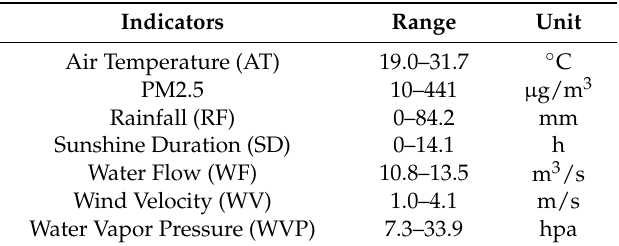
Table 2. Data ranges of seven external environmental